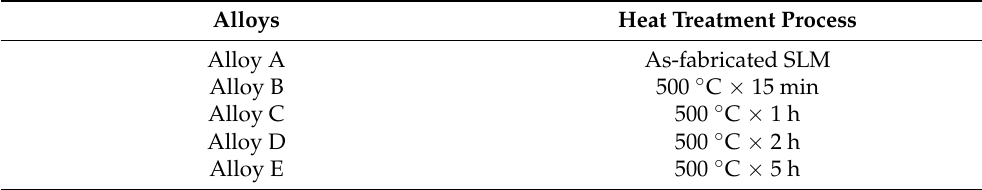
Figure 1. ( a ) Schematic diagram of processing, ( b ) schematic diagram of scanning strategy. Table 3. The holding heat treatment times of AlSi10Mg fabricated by